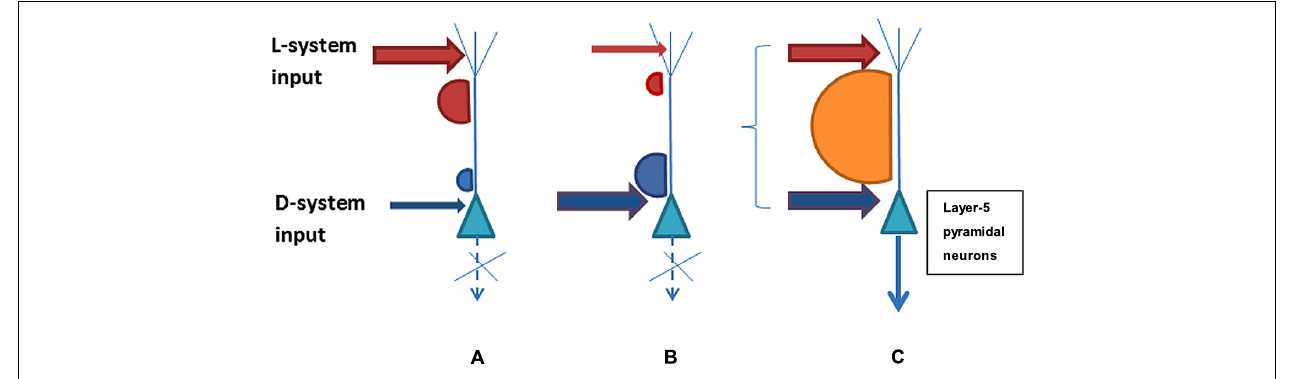
D-system presynaptic input is present but the L-system contribution is weak or incoincident. Both (A) and (B) represent scenarios lacking consciousness with its contents. In contrast, variant (C) illustrates sufficiently strong and synchronous presynaptic input from the D- and L-systems that leads to plateau-wave of activity and integration of the neuron’s contentful contribution to the phenomenal field of